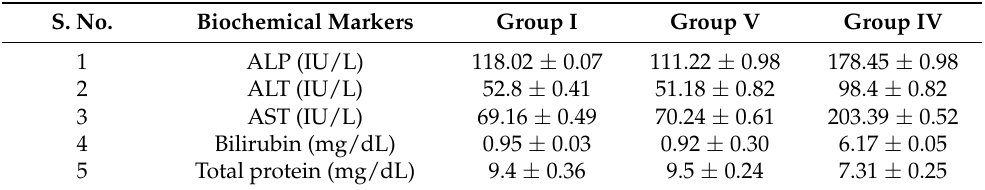
Table 2. Biochemical parameters of Albino mice in acute toxicity study.